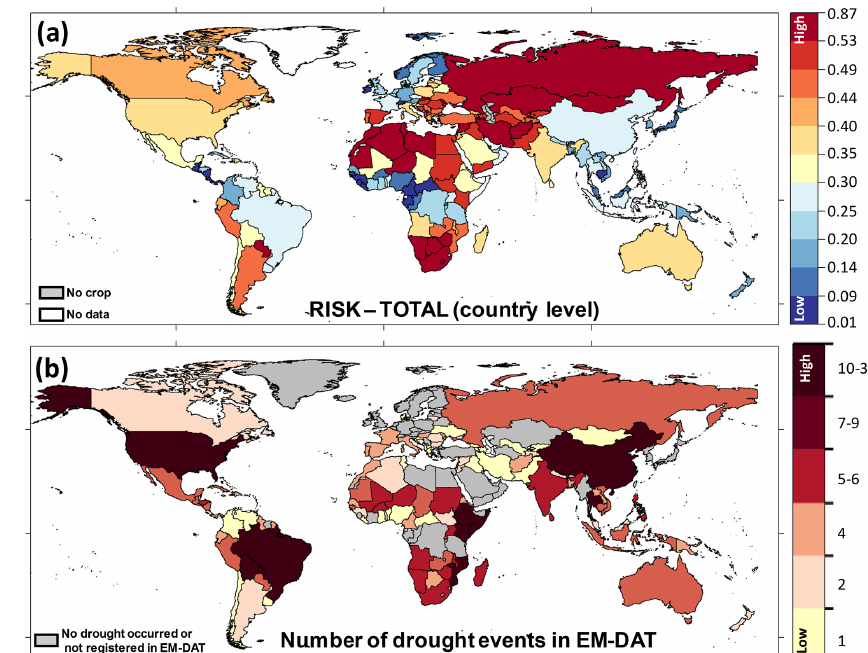
Figure 6. Comparison of total risk against drought impact